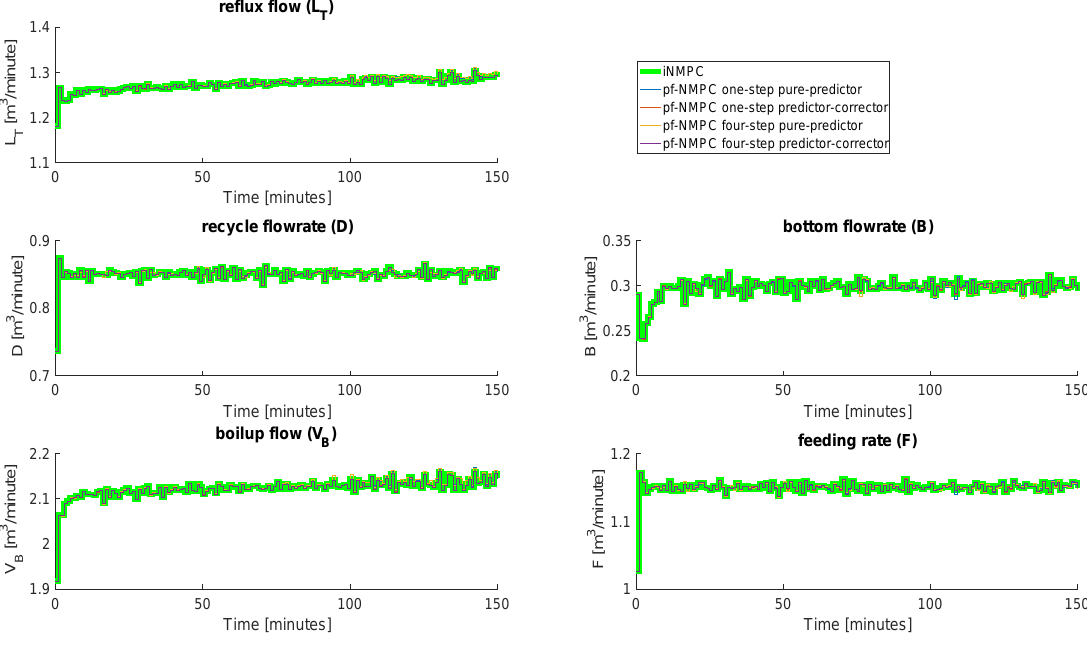
Figure 7. Optimized control inputs.